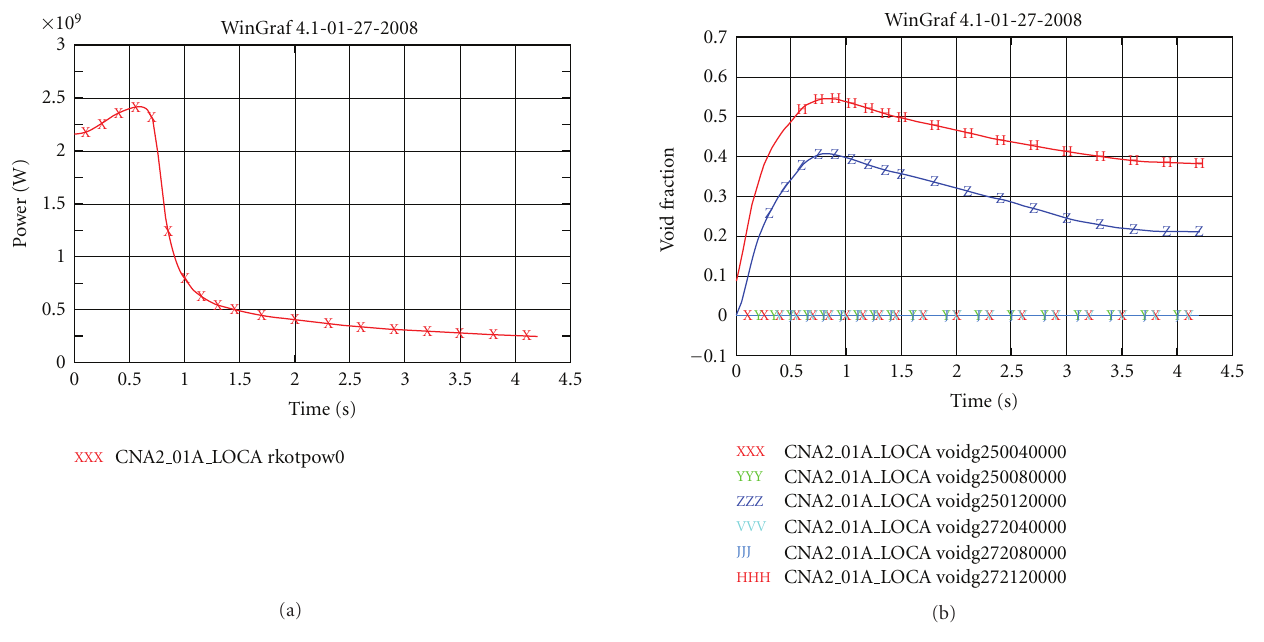
Figure 12: Reactor power (W) and void fraction in central and hot